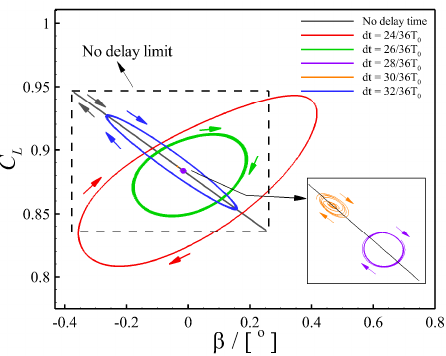
Figure 6. Comparison of phase graph of C L vs. β with different ∆ t under k T = 0.01. The comparison of t he 𝐶 (cid:3043) and 𝐶 (cid:3033)(cid:3051) distributions between the flows with and without